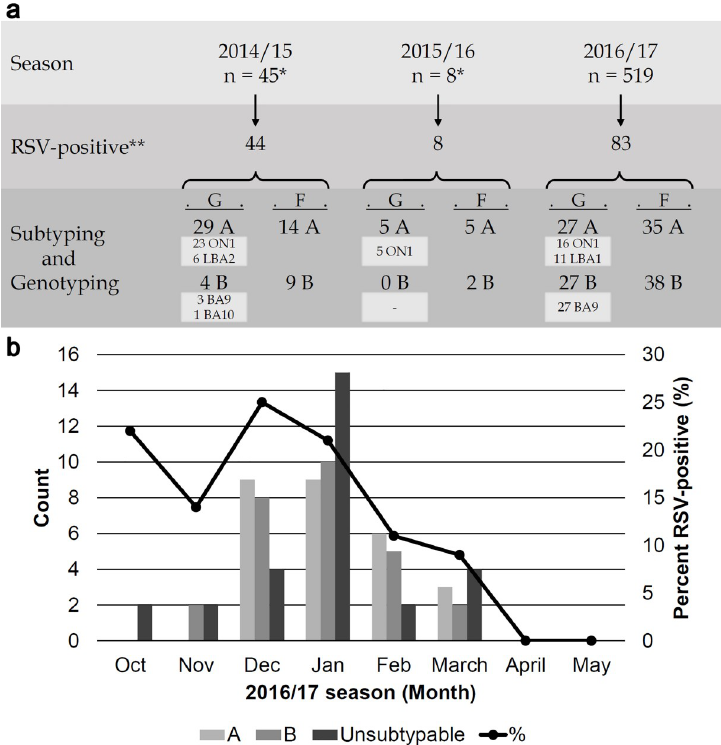
Fig 1. Distribution of RSV positive specimens. (a) Total count of RSV positive samples by season, subtype and genotype. � Indicates RSV-positive by a rapid-detection kit. �� Indicates RSV-positive by real-time RT-PCR. (b) Monthly count of RSV positive samples by subtype and percent positive during the 2016/17 season. Samples for which G gene sequences could not be obtained were indicated as